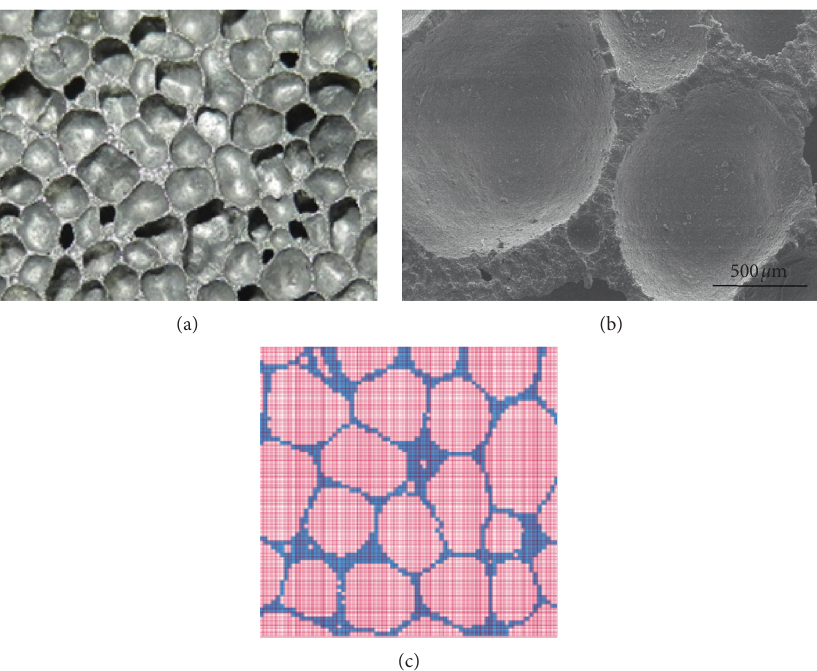
Figure 10: The real structure and numerical simulation structure of aluminum